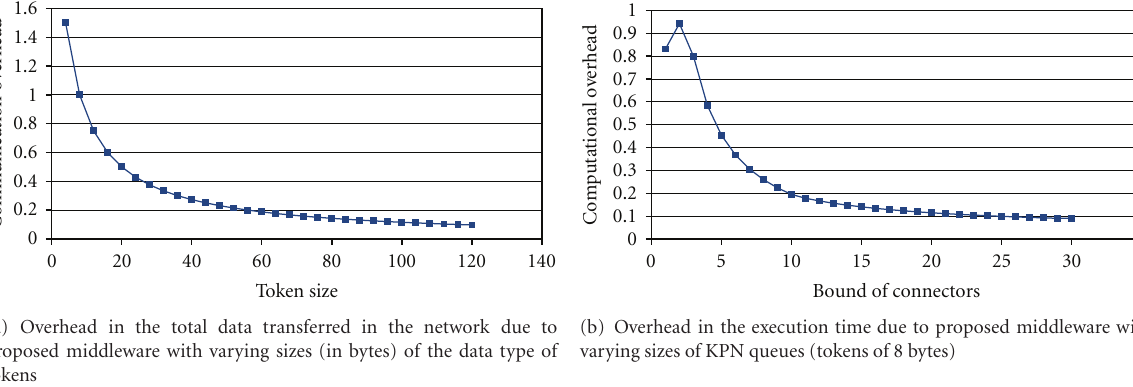
Figure 10: The communication and computational overhead due to the proposed middleware for the JPEG encoder/decoder case study.